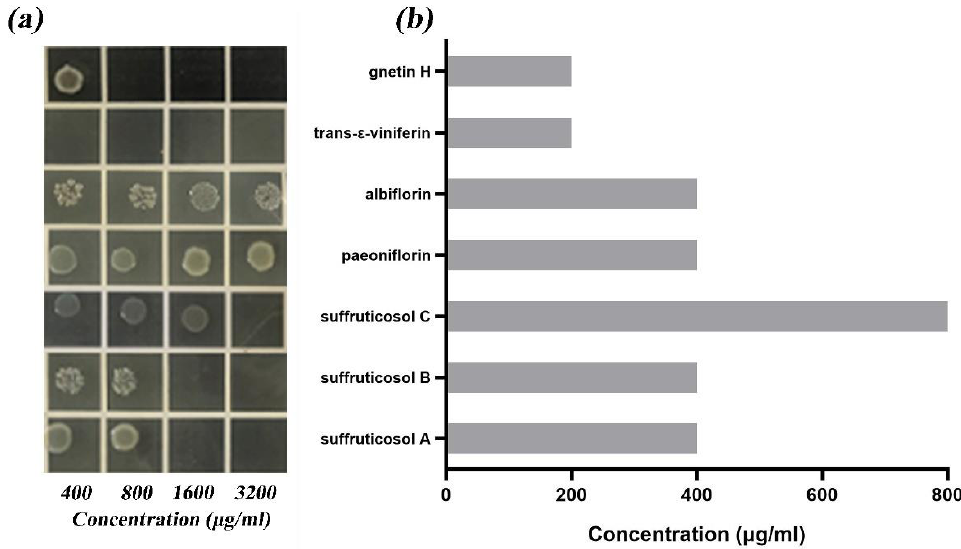
Figure 1. MIC and MBC values of each component of peony seed meal against S. suis . ( a ) MBC values ( b ) MIC values. In the figure, ( a ) MIC results and ( b ) MBC results are corresponding, which are suffruticosol A, suffruticosol B, suffruticosol C, albiflorin, paeonifloin, trans- ε -viniferin, gnetin H from bottom to top.